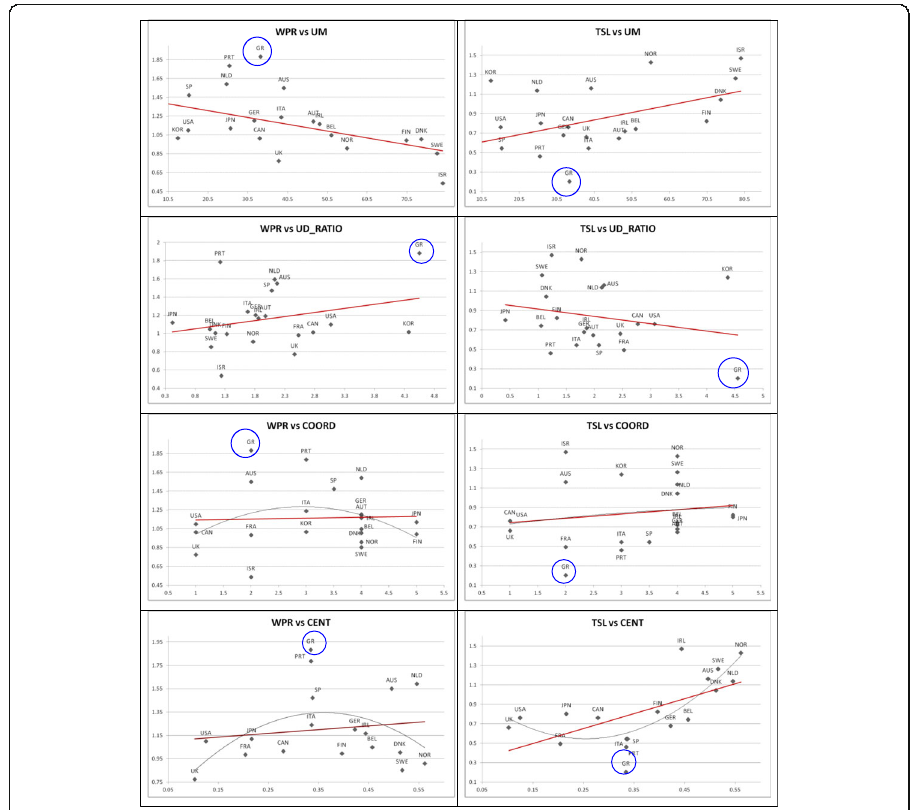
Fig. 12 Labor Institutions. Note : (i) Median values (maximum time span 1970 – 2010), (ii) the red line is the linear regression line, and (iii) the black curved line is the second-order regression line